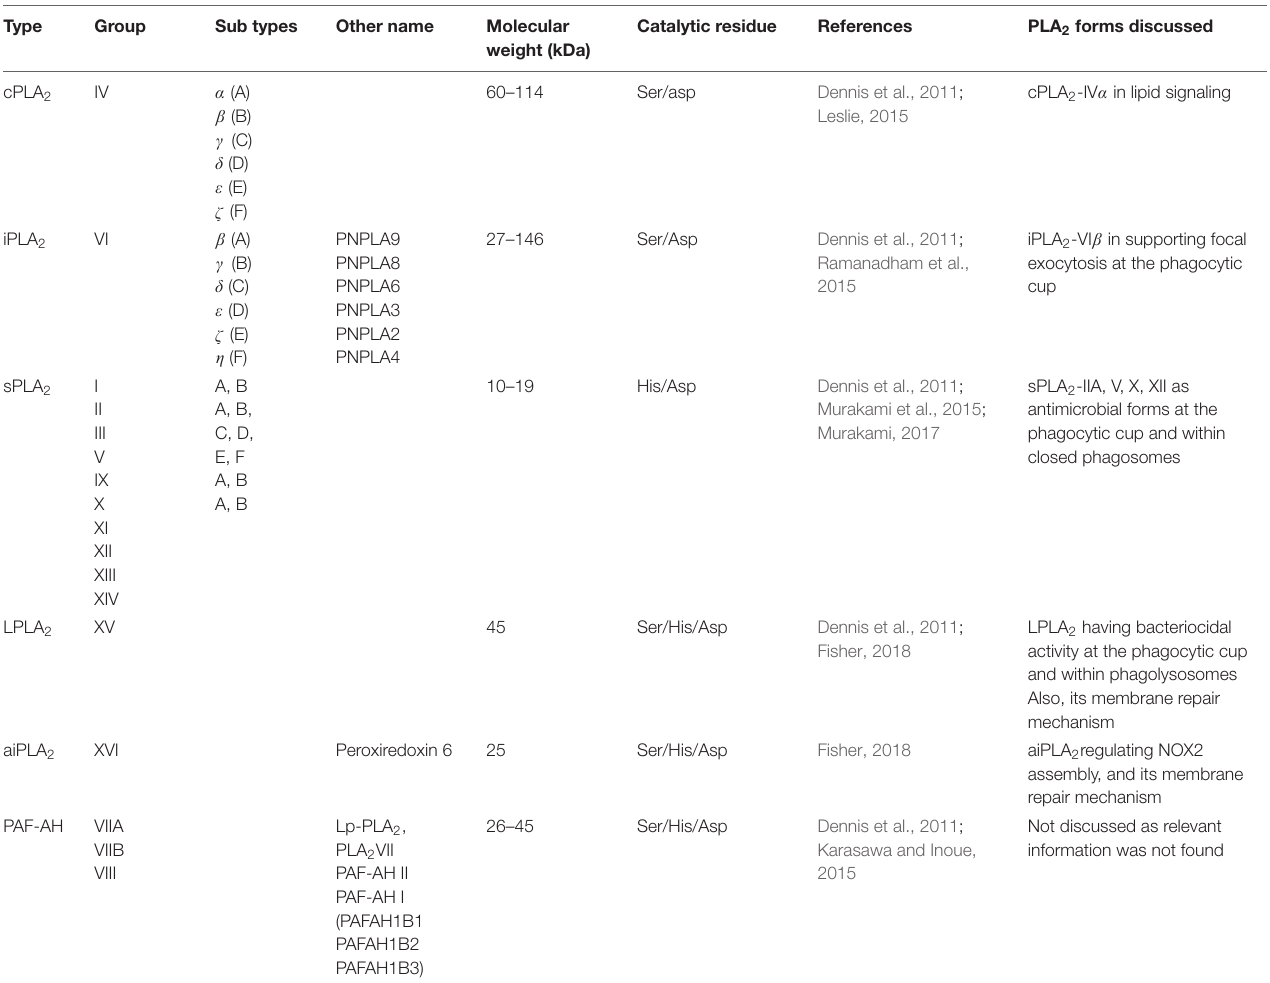
TABLE 1 | Phospholipase A 2 (PLA 2 ) family and role of specific forms discussed in this